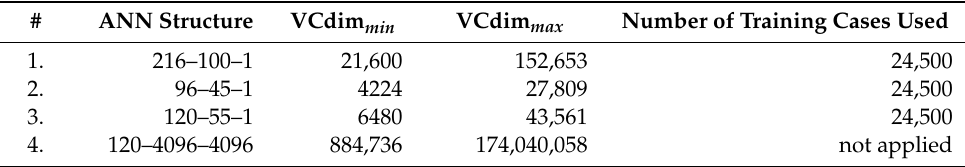
Table 1. Vapnik–Chervonenkis dimensions for selected structures of ANNs.